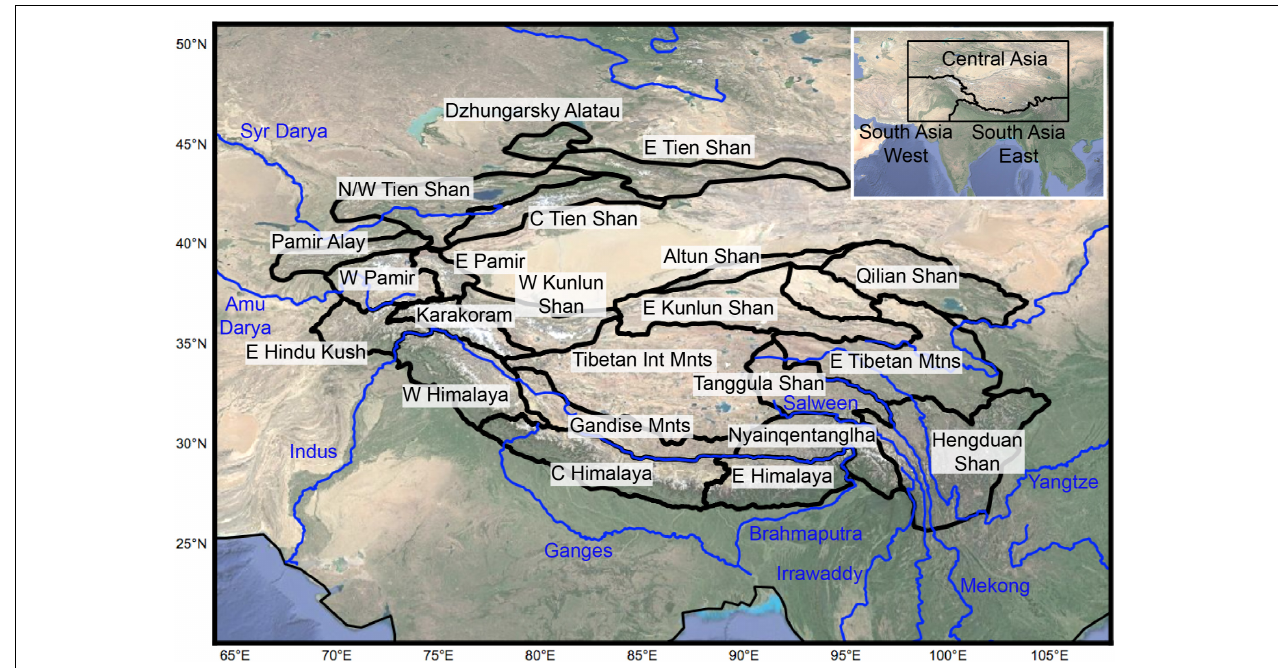
FIGURE 1 | Map of High Mountain Asia showing subregions according to Bolch et al. (2019) (black) and some of the major rivers (blue). Inset shows the location of High Mountain Asia with the three primary RGI regions (RGI Consortium, 2017). Background map data: Google, Digital Globe.